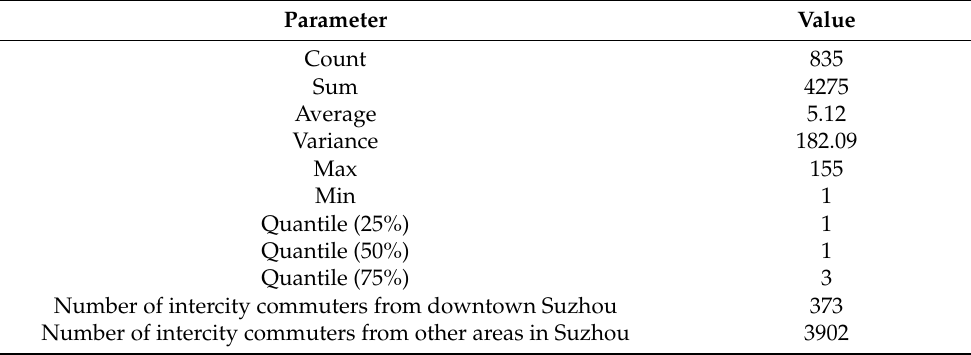
Figure 4. Intercity commuting flows at township level. Table 2. Descriptive statistics of the intercity commuting flows at township level.